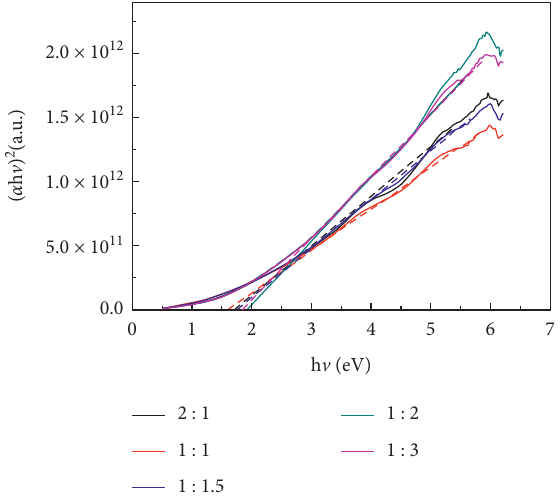
Figure 6: ( αE 2 versus E photon ) photon plots of all